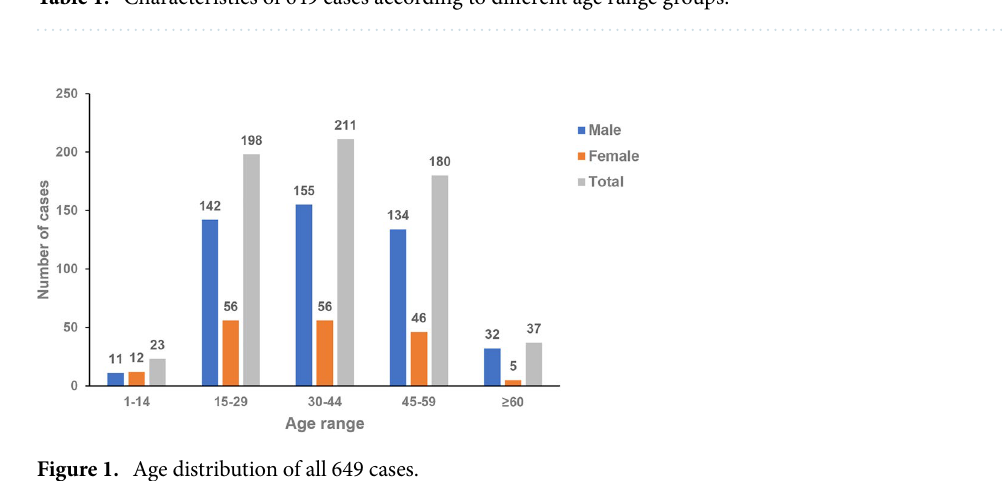
Table 1. Characteristics of 649 cases according to different age range groups.